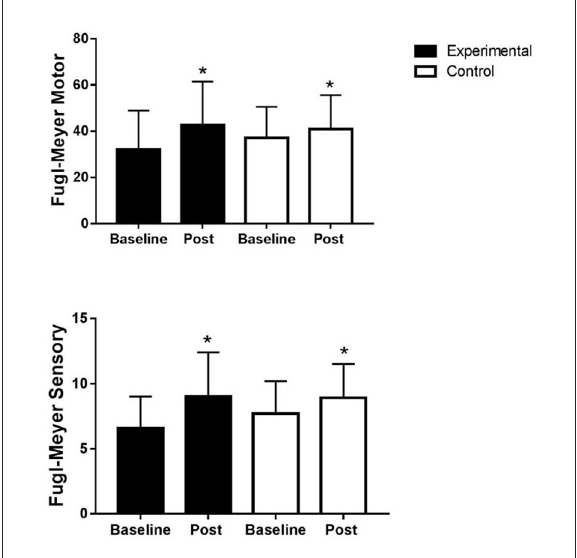
FIGURE3 Motor and sensory function of the upper limb assessed by Fugl-Meyer. Fugl-Meyer experimental motor domain (32.1 ± 16.8 vs. 42.6 ± 18.8), sensory domain (6.6 ± 2.4 vs. 9 ± 3.4), control motor domain (37 ± 13.6 vs. 40.9 ± 14.7), and sensory domain (7.7 ± 2.5 vs. 8.9 ± 2.6). *Wilcoxon test, p ≤